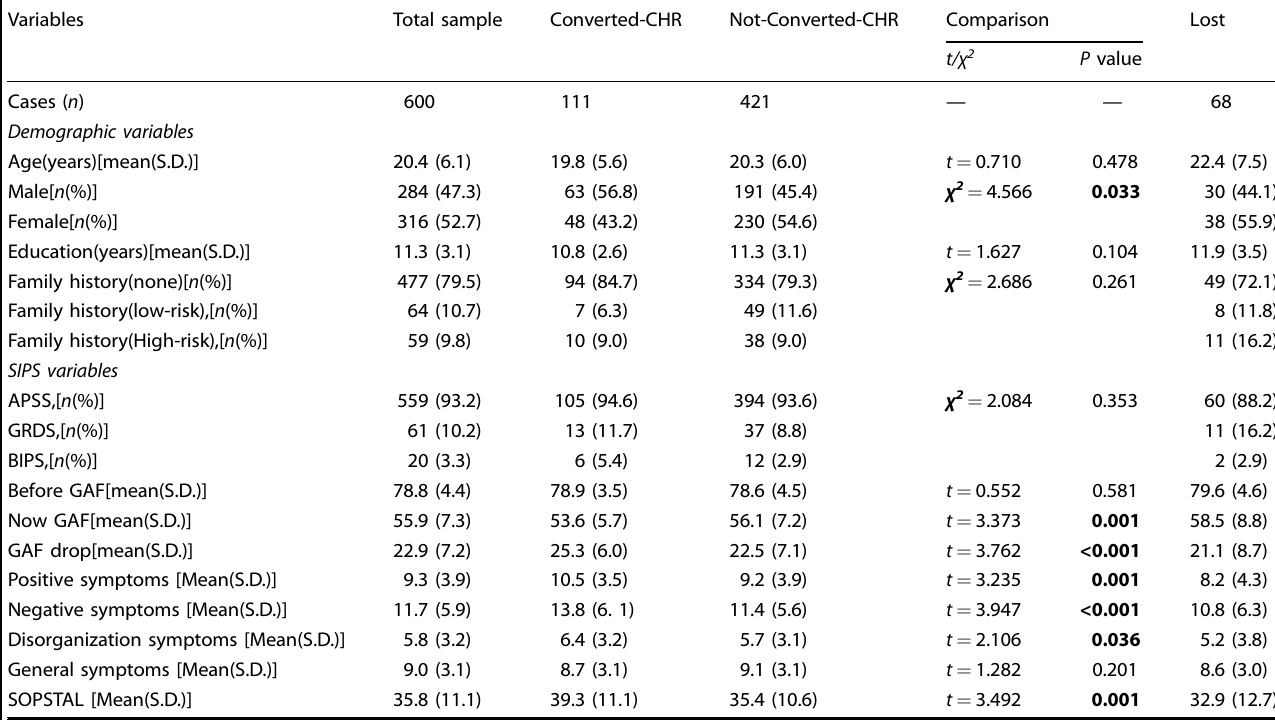
Table 1. Baseline demographic and SIPS variables, comparison between converted-CHR and not-converted-CHR.